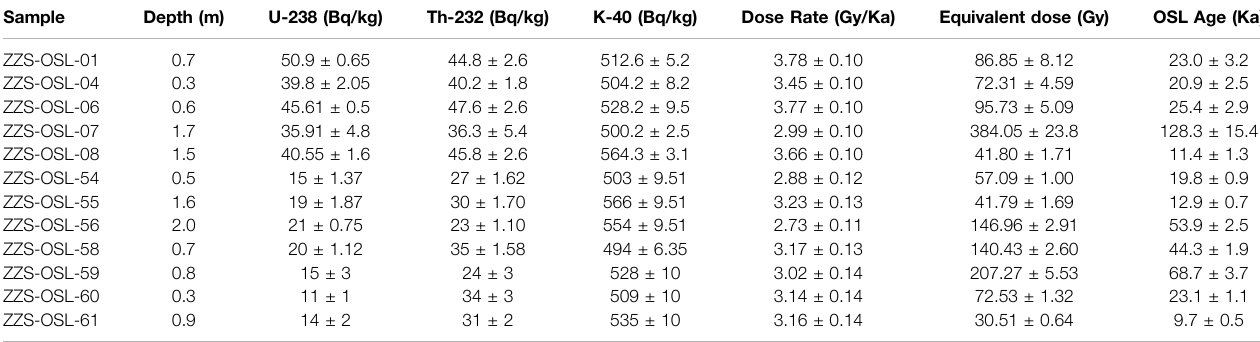
TABLE 1 | Result of OSL analysis for the samples on the ZWPF.